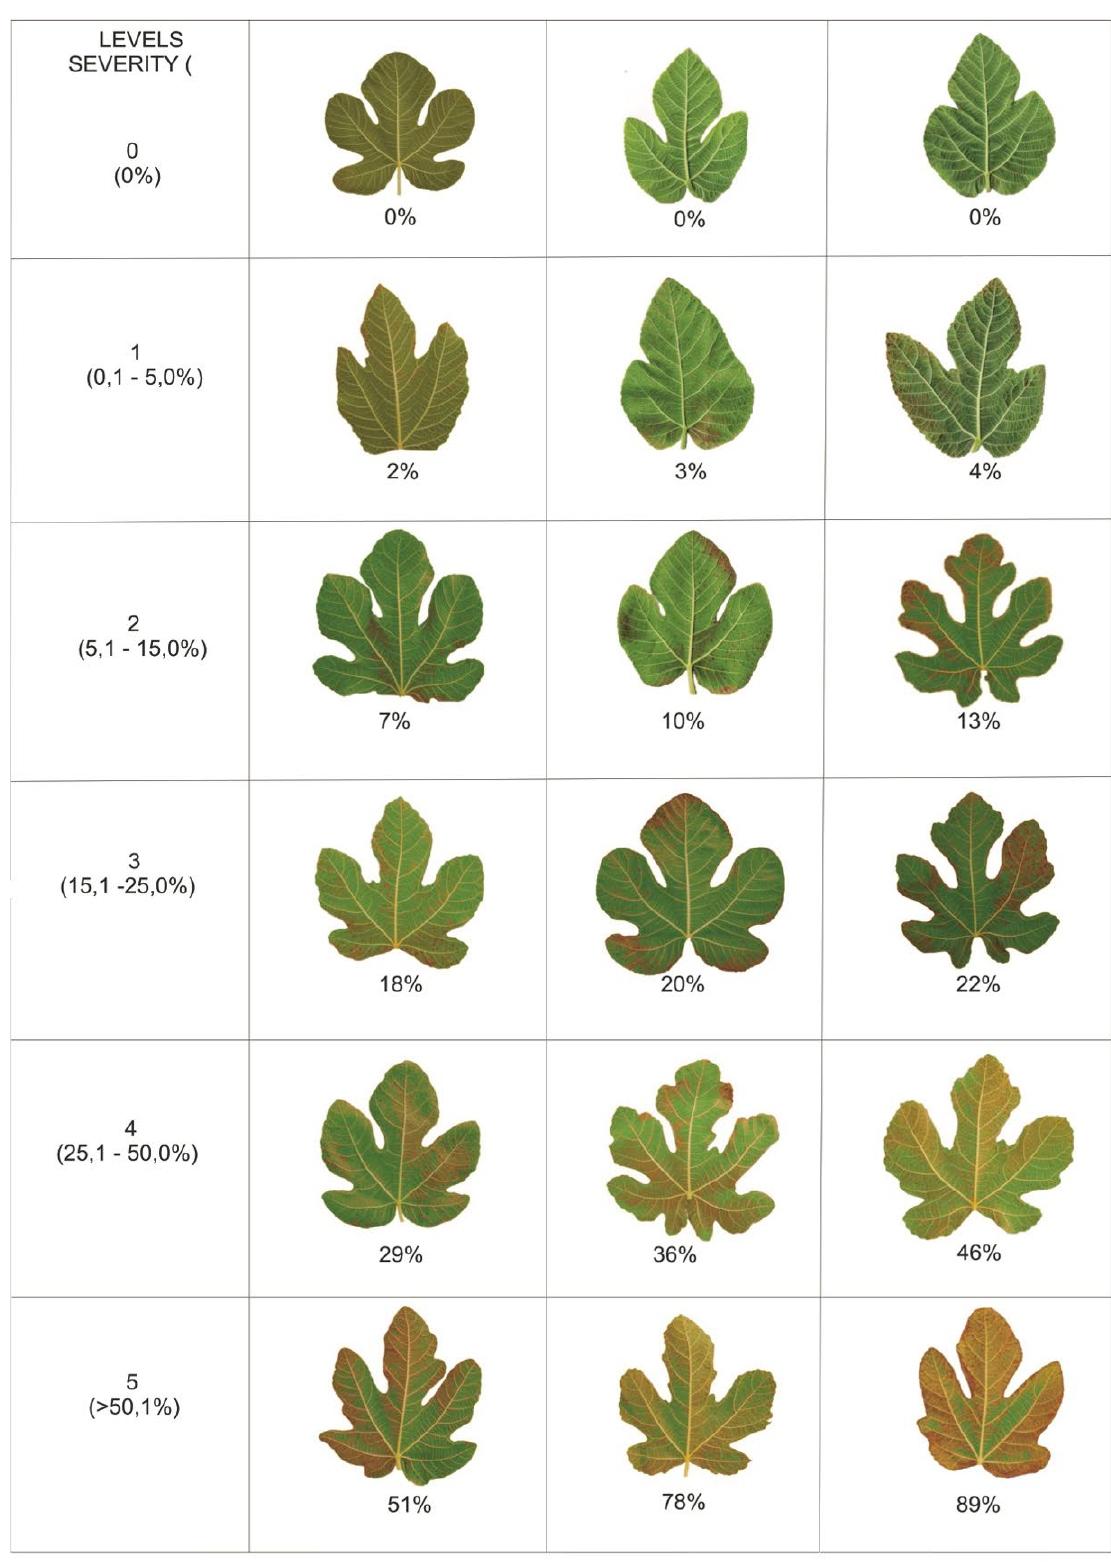
Figure 1. Diagrammatic scale for assessment of rust severity on fig leaves. The numbers represent percentages of leaf area diseased. leaf